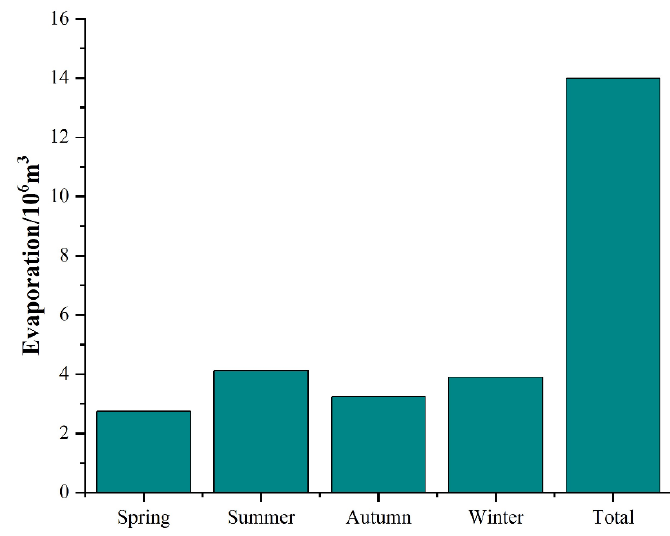
Figure 5. Evaporation from human body in Beijing.